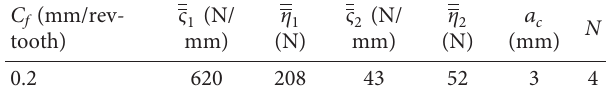
Table 2: Coefficients of cutting forces [21].